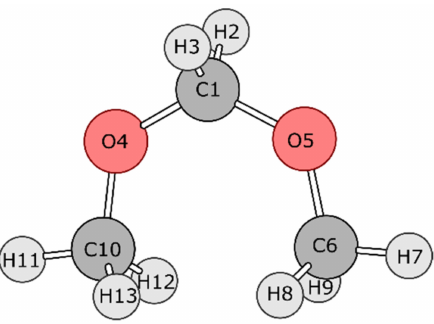
Figure 1. Optimized ( a ) gg and ( b ) tt conformations of DMM.